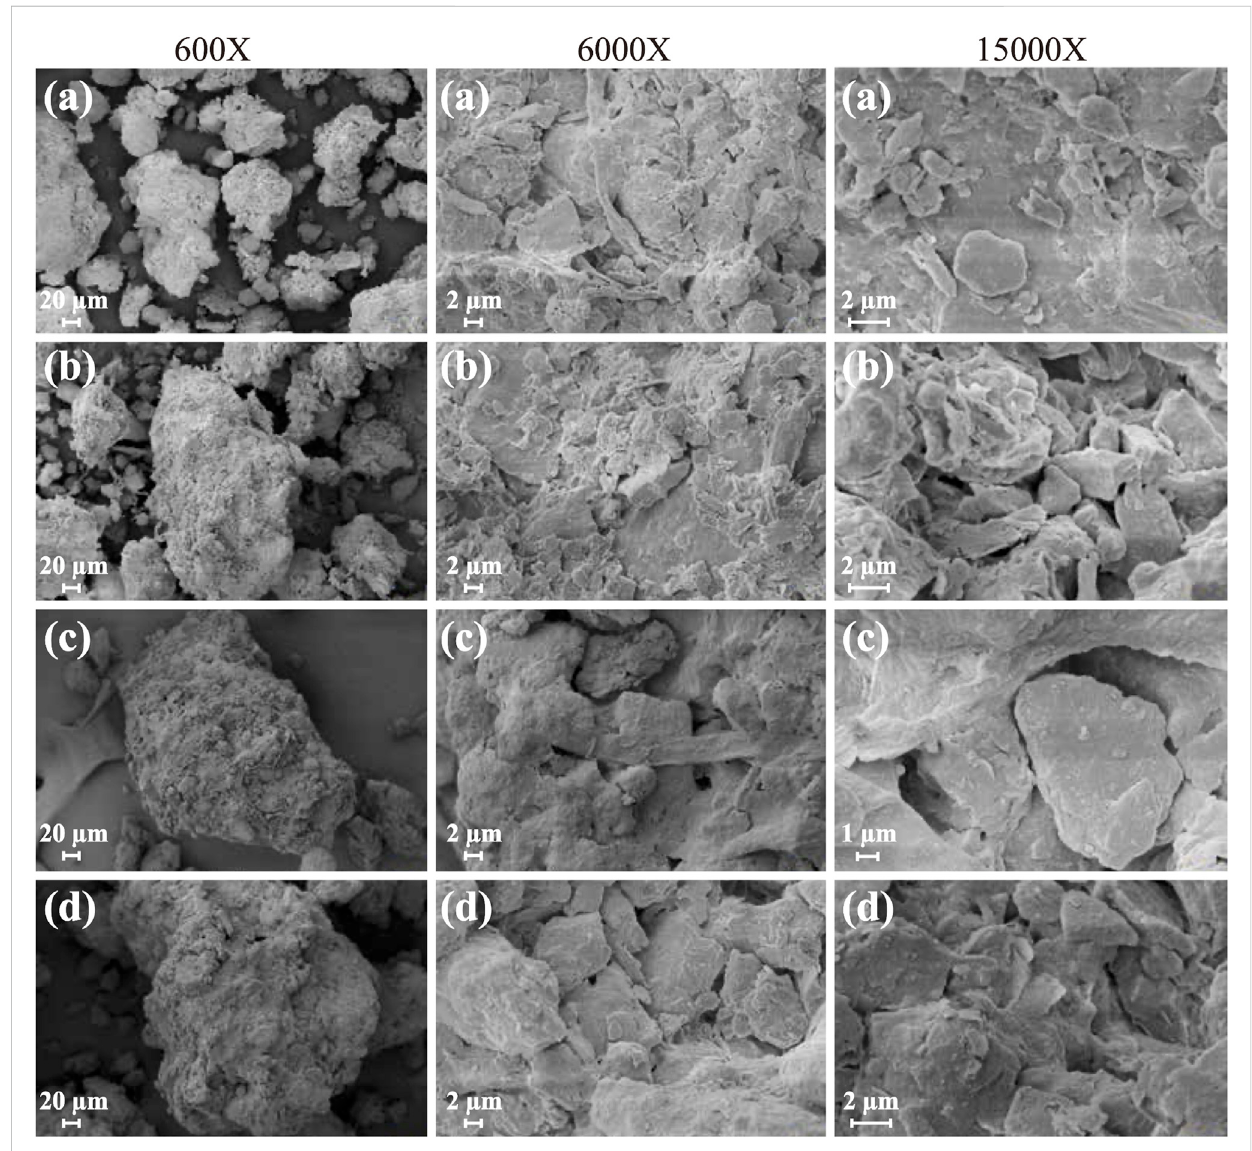
FIGURE 2 SEM photographs of soil microaggregates at × 6000 magni fi cation; (A – D) represent forests, shrublands, terraces, and cultivated land,